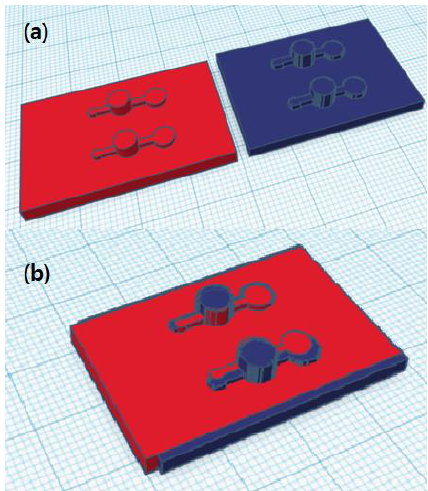
Figure 2. Comparison between template model generated by conventional design tools and MineLoC generated model: ( a ) side-by-side comparison; and ( b ) overlapped comparison. The red model was generated by the conventional software and the blue model was generated by the proposed method.